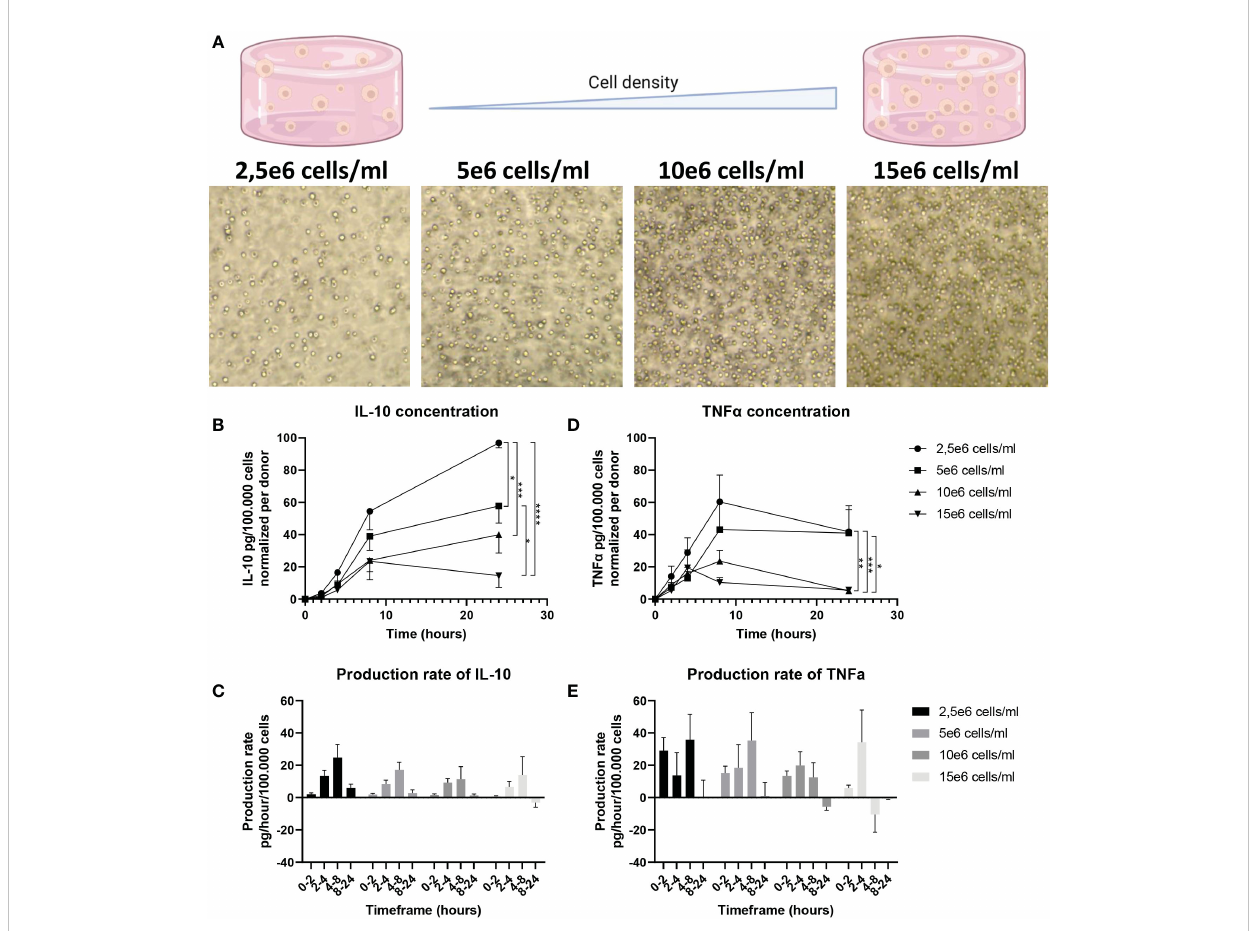
FIGURE 6 Effect of cell density on IL-10 secretion in 3D bulk cultures. (A) Bright fi eld microscopy images of cells at different densities in an agarose hydrogel. (B) IL-10 production over 24h quanti fi ed using ELISA for all 4 cell densities. IL-10 was normalized per donor to 100.000 cells. (n=7